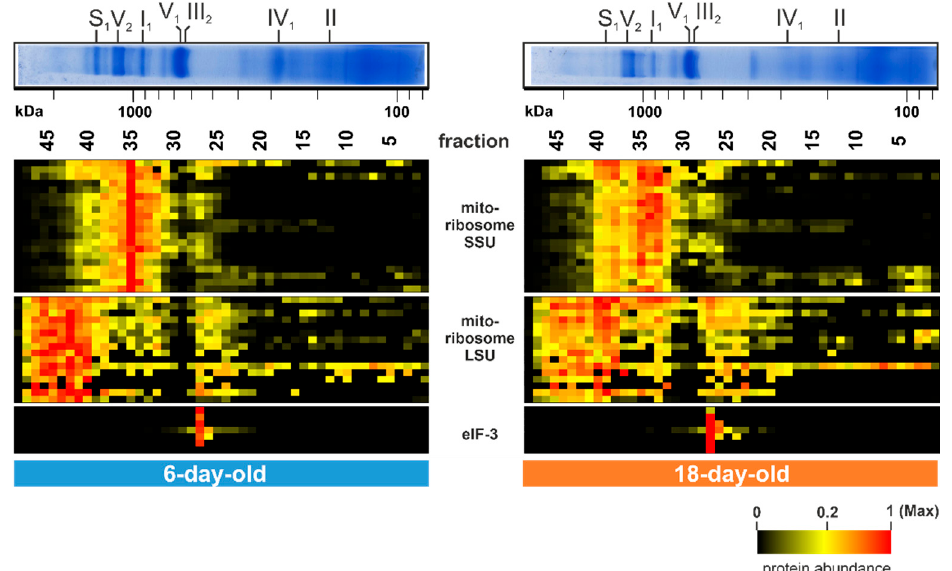
Figure 5. Translation of mitochondrial proteins alters during aging. Quantified proteins of the mitochondrial ribosome (large subunit; LSU and small subunit; SSU) and the translation initiation factor 3 (eIF-3) are represented in a heat map. The color scale ranges from black (not identified), to yellow (20% of the maximum), to red (maximum abundance). For detailed information about the corresponding proteins refer to Table S1E.